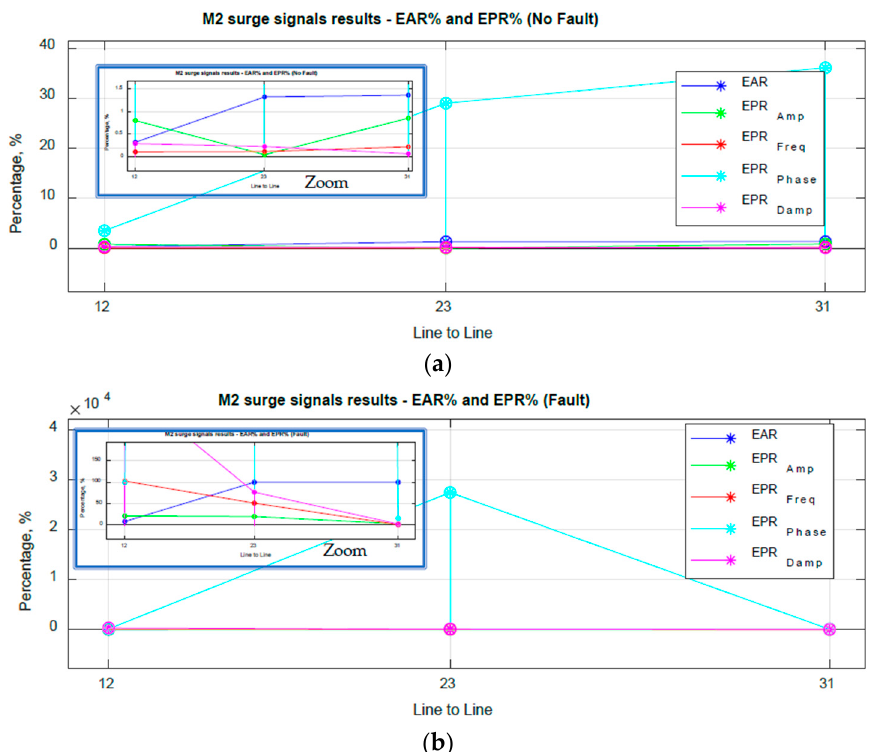
Figure 10. EAR% and EPR% index results comparison of M2 surge signals. ( a ) No fault ( b )